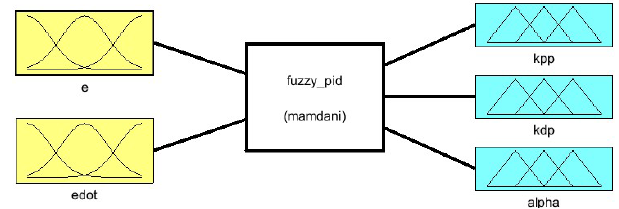
Figure 16. Mamdani Model of Fuzzy Based PID Controller for